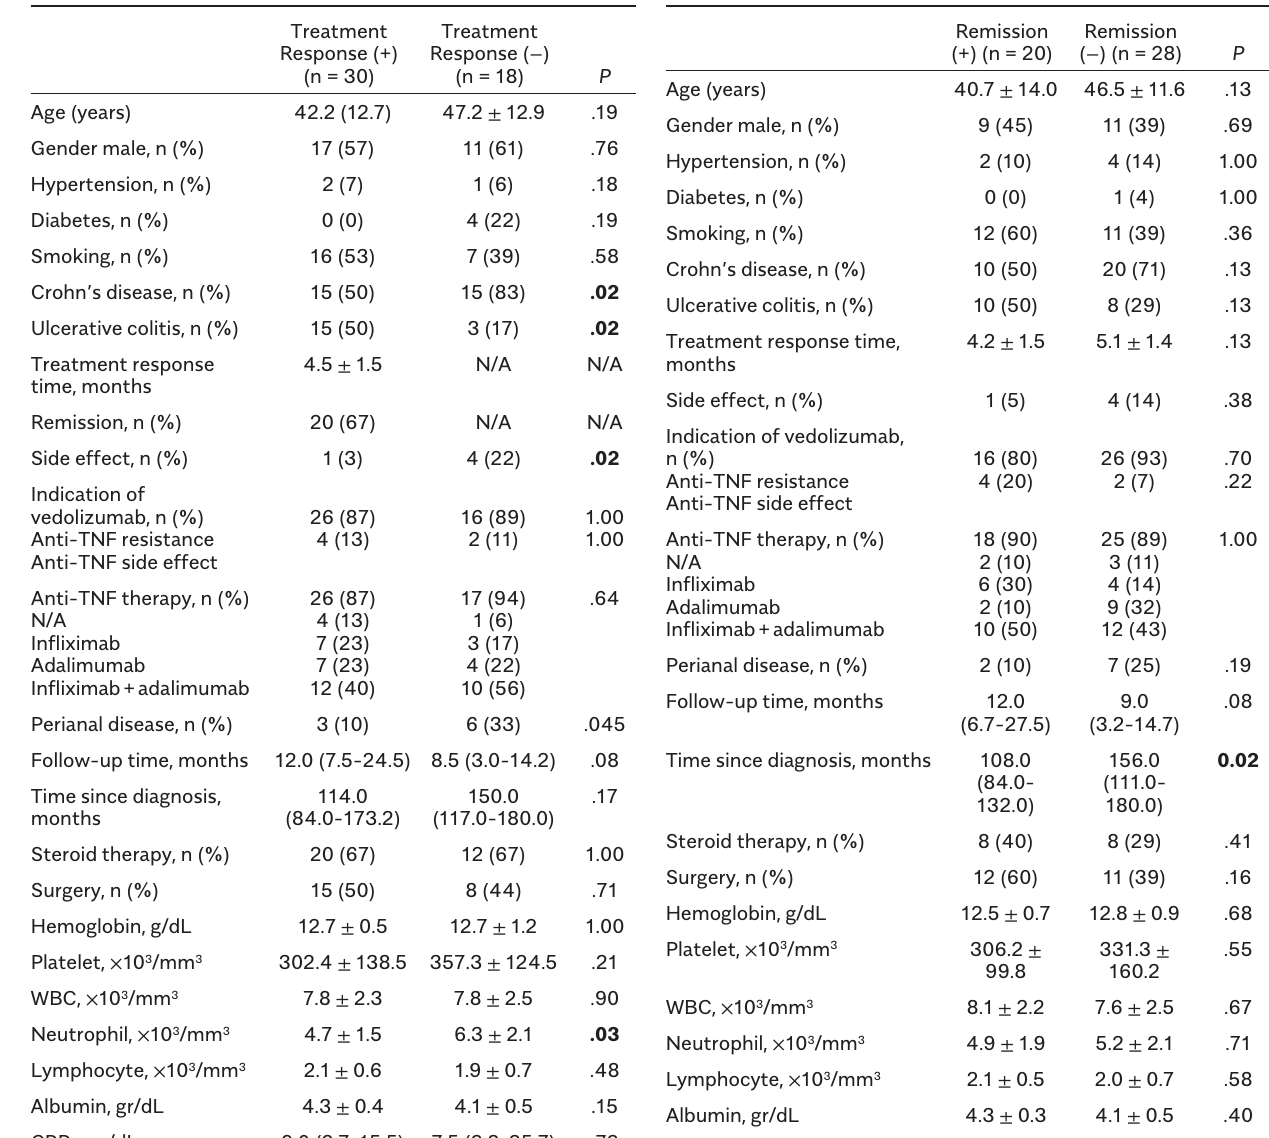
Table 5. Baseline Clinical and Laboratory Parameters According to